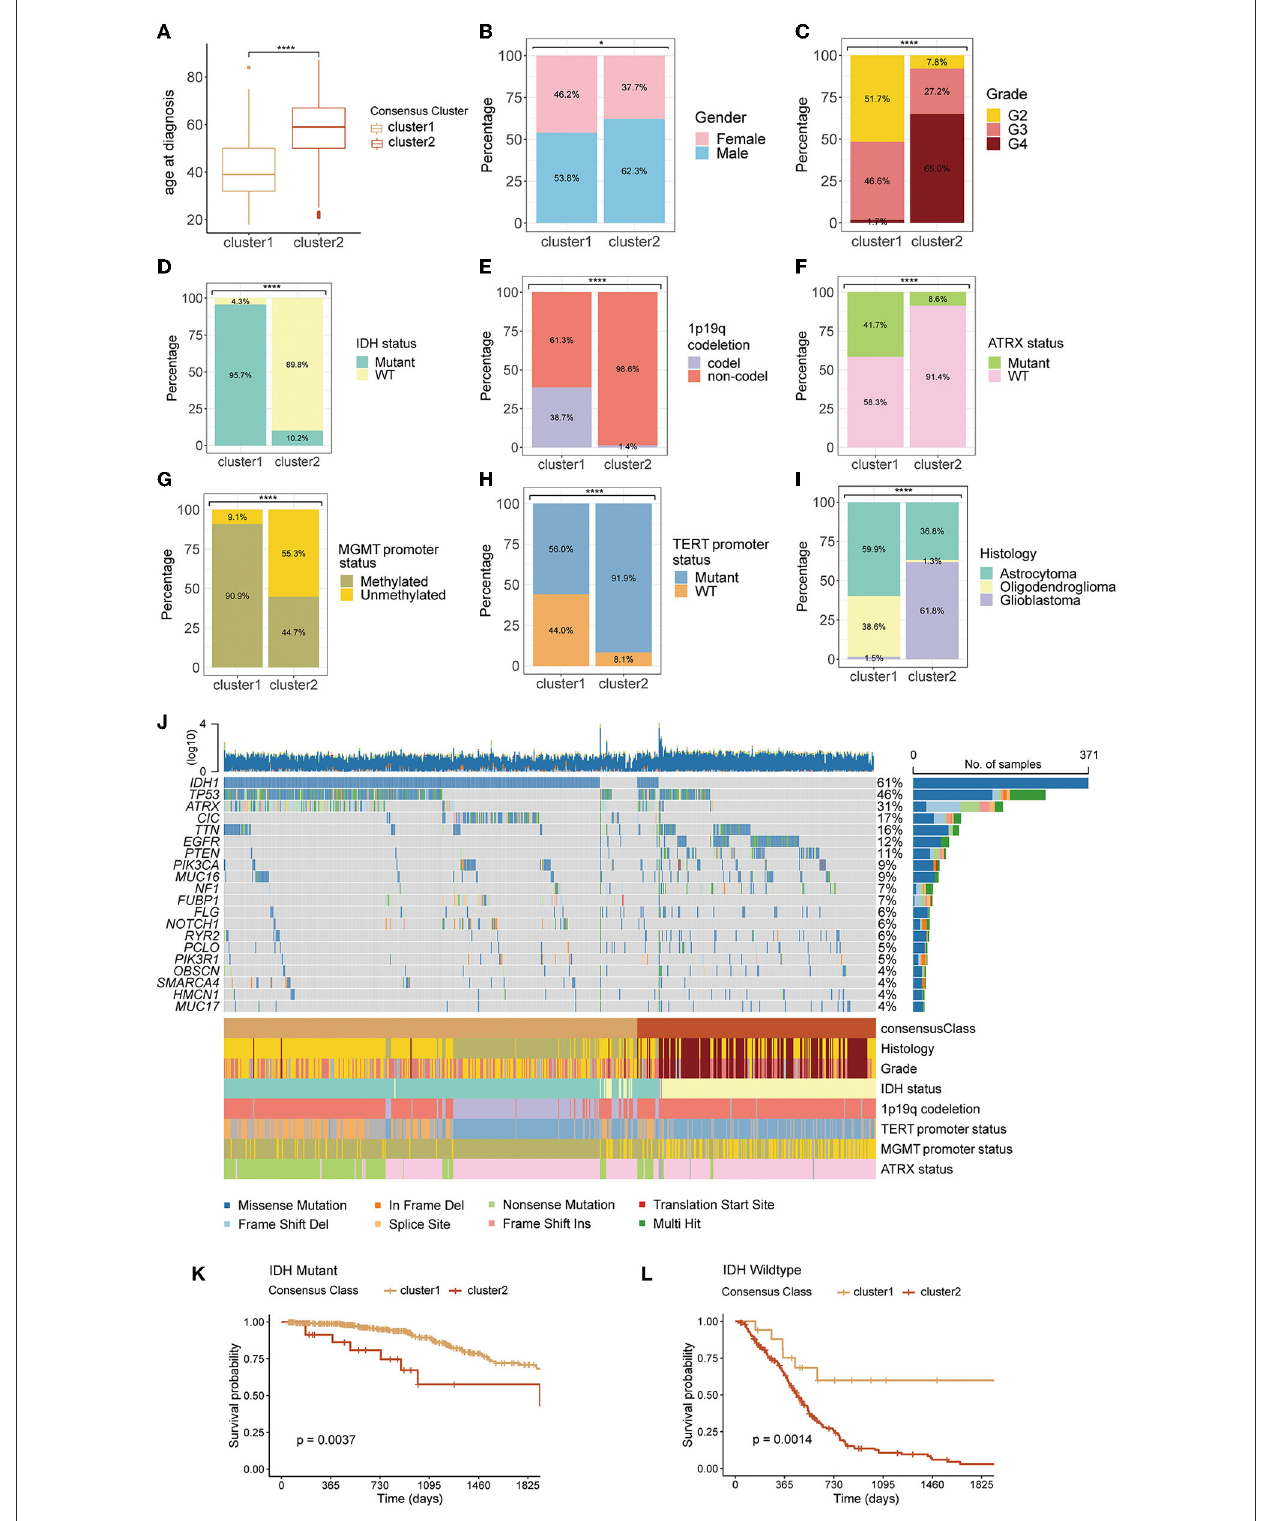
FIGURE2 Differences in clinicopathological variables between clusters 1 and 2: age at diagnosis (A) , gender (B) , WHO grade (C) , IDH mutation status (D) , 1p19q codeletion status (E) , ATRX mutation status (F) , MGMT promoter status (G) , TERT promoter status (H) , and histology (I) , the waterfall plot depicting the top 20 mutant genes in the entire TCGA cohort (J) , difference between clusters 1 and 2 in overall survival for patients with IDH-mutant (K) , or IDH-wildtype gliomas (L) . WHO, World Health Organization; IDH, isocitrate dehydrogenase; codel, codeletion; TERT, telomerase reverse transcription; MGMT, O6-methylguanine-DNA methyltransferase; ATRX, alpha thalassemia/mental retardation syndrome X-linked protein/gene; TCGA, The Cancer Genome